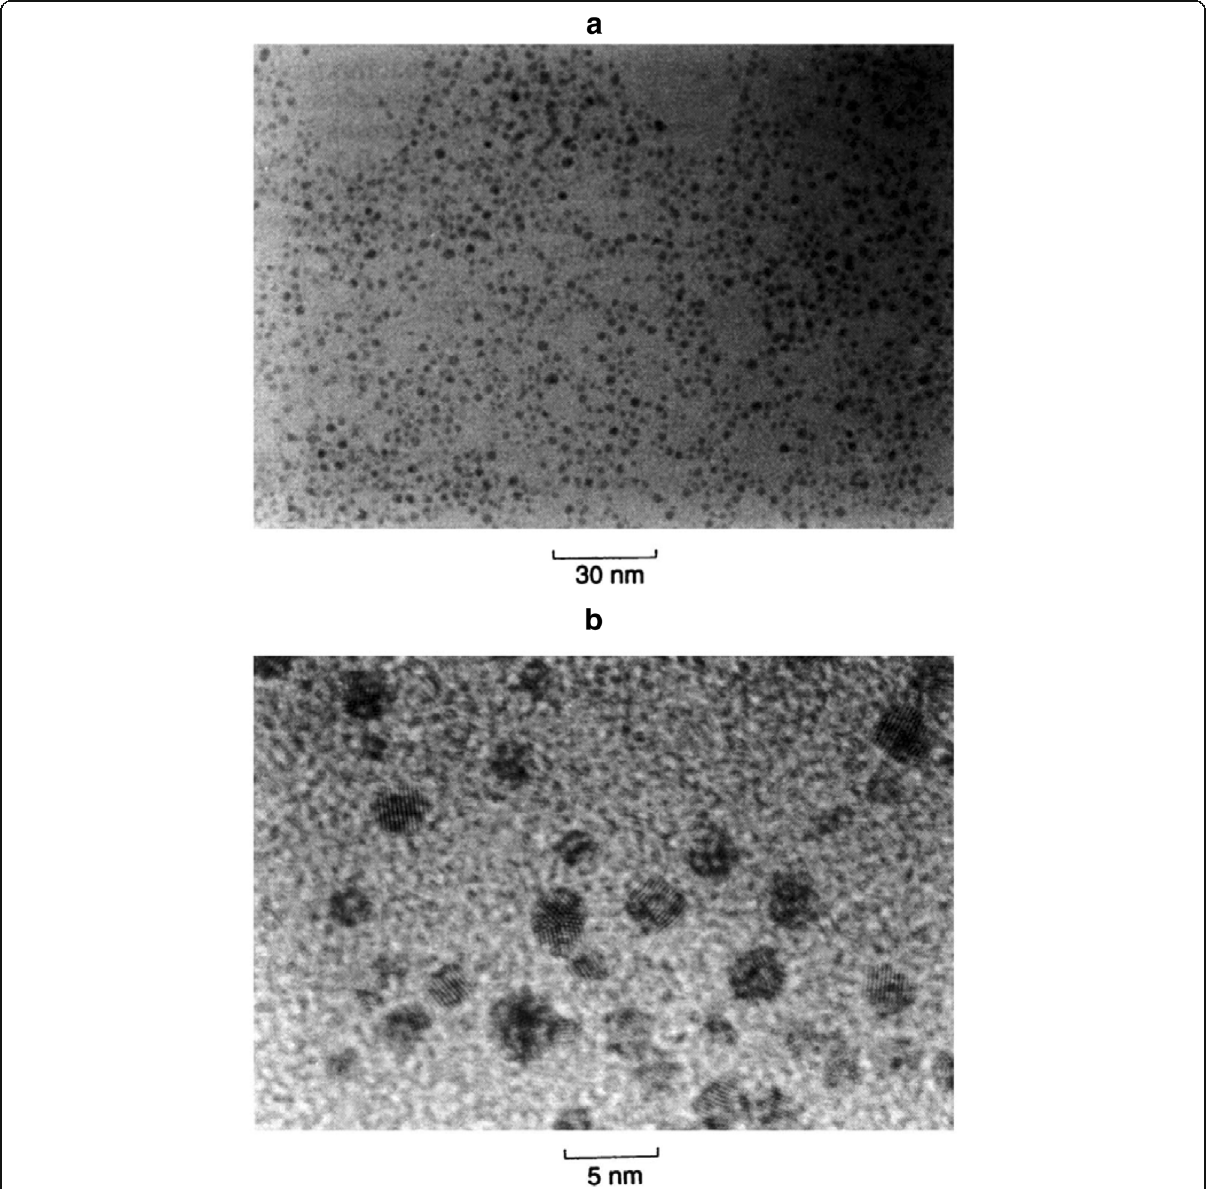
Fig. 2 TEM pictures of the thiol derivatized gold nanoparticles at a low and b high magnification [147]. Reprinted with permission from